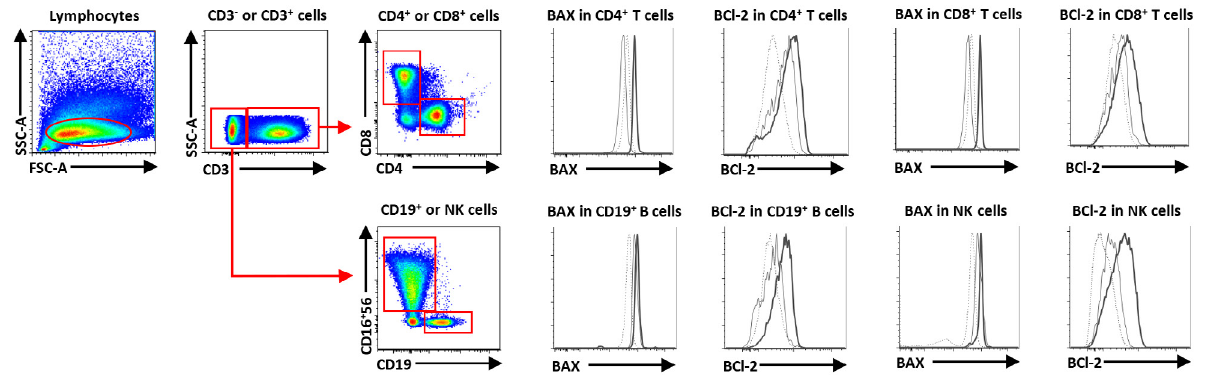
Figure 1- Gating strategy of PBMCs via flow cytometry. Lymphocytes were gated from FSC and SSC based on size and granularity. CD3 was used to identify T cells (CD3 + ) or non-T cells (CD3 - ). Staining with CD4 and CD8 antibodies against CD4 and CD8 T cells from CD3 + T cells and CD19 Ab for B cells and CD16/56 Ab for NK cells from CD3 - T cells. Gated Bax and Bcl-2 expression of immune cells represented by mean fluorescence intensity (MFI). Bax and Bcl-2 expression in HC (dash line), low-expression OC (black line), and high-expression OC (solid black line)